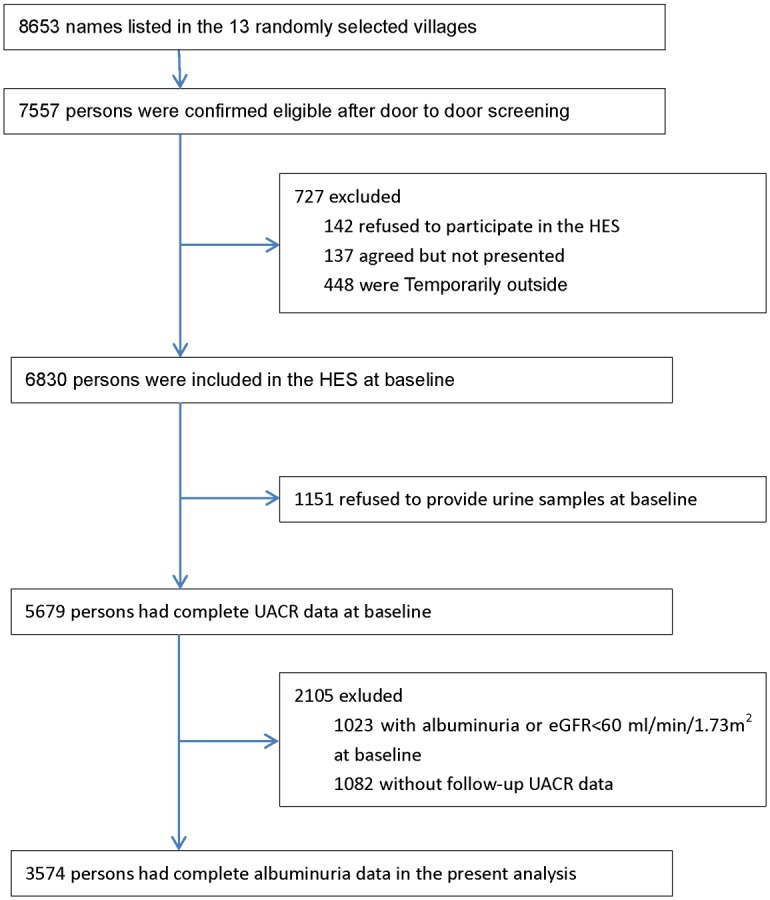
Flow diagram of recruitment of participants in the analysis.